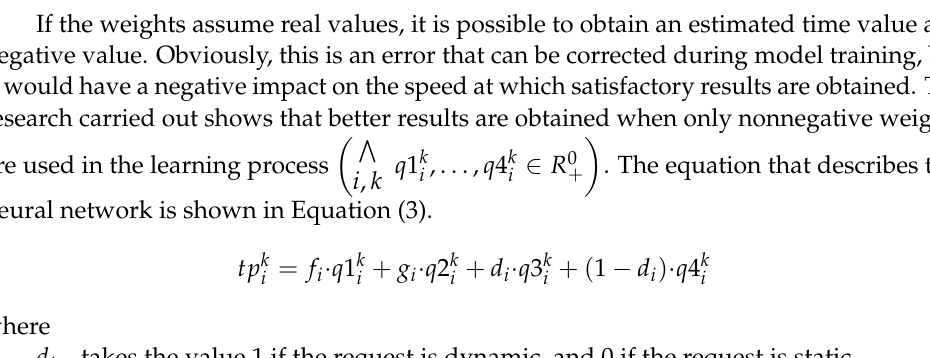
Figure 6. Initial diagram of the executor model ( NM k )